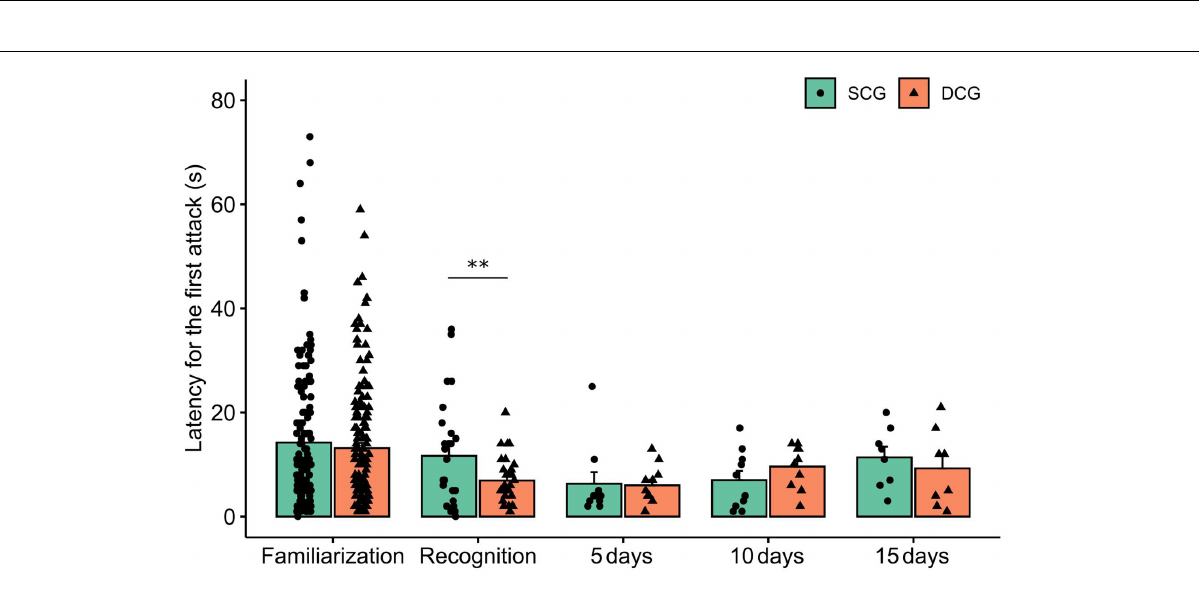
FIGURE 3 | Latency to the first attack in each experimental phase. Bars (Mean + SE) indicate latency to the first attack of damselfish Stegastes fuscus . Two-way ANOVA was performed and the asterisk indicates a significant value in the comparison between the SCG and DCG during the recognition experimental phase (two-way ANOVA; p =